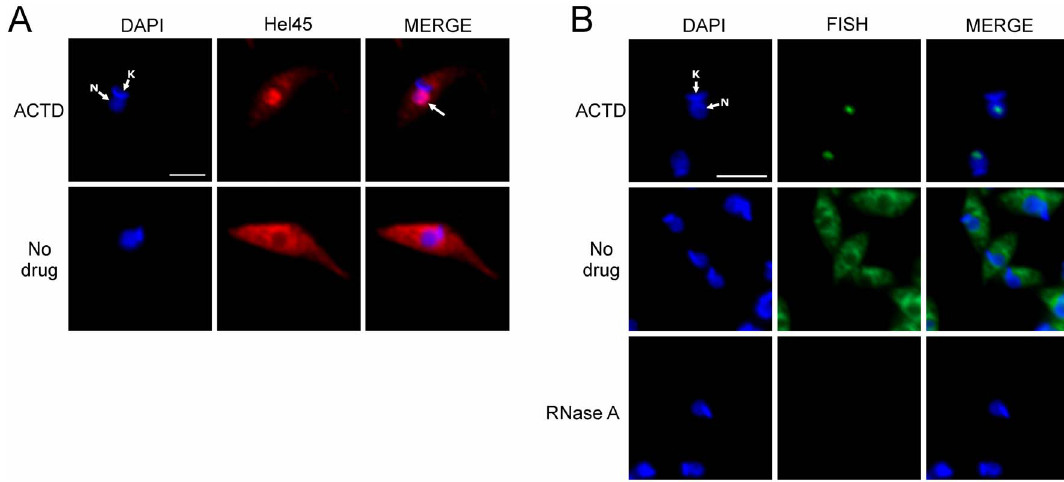
Figure 5. Localization of Hel45 after actinomycin D treatment in T.cruzi . Detection of exogenous Hel45 (A) tagged with PTP at the NT by indirect immunofluorescence with an anti-ProtA antibody and of mRNA (B) by fluorescence in situ hybridization (FISH) with a digoxigenin-conjugated oligo(dT) probe in T. cruzi after treatment with 50 m g/ml actinomycin D (ACTD) for 24 hours. Probe detection was carried out by indirect immunofluorescence with anti-DIG mouse monoclonal antibodies (Sigma-Aldrich, 1:300 dilution) followed by secondary Alexa Fluor 488-conjugated antibodies (1:600 dilution). As a control, 100 m g/ml RNase A was incubated with the parasites before probe hybridization (RNase A). DAPI=DNA stained with DAPI. Hel45= localization of tagged Hel45. MERGE=merged images for DAPI staining and Hel45 or mRNA localization. N=nucleus. K=kinetoplast. Arrows=parasites with nuclear accumulation of tagged Hel45. Bar=5 m m.